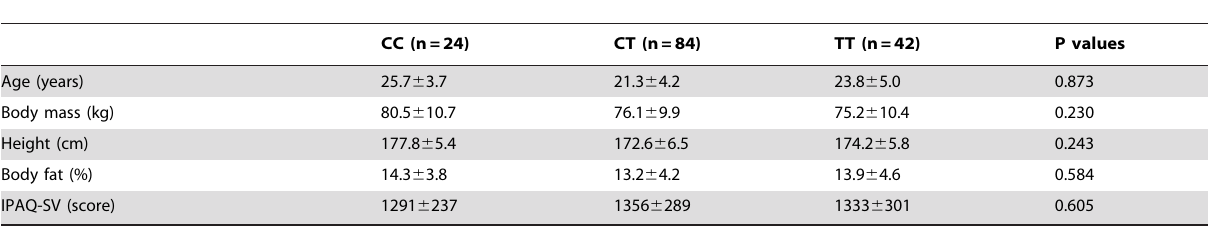
Table 1. Anthropometric characteristics and physical activity levels of the subjects in the three genotype